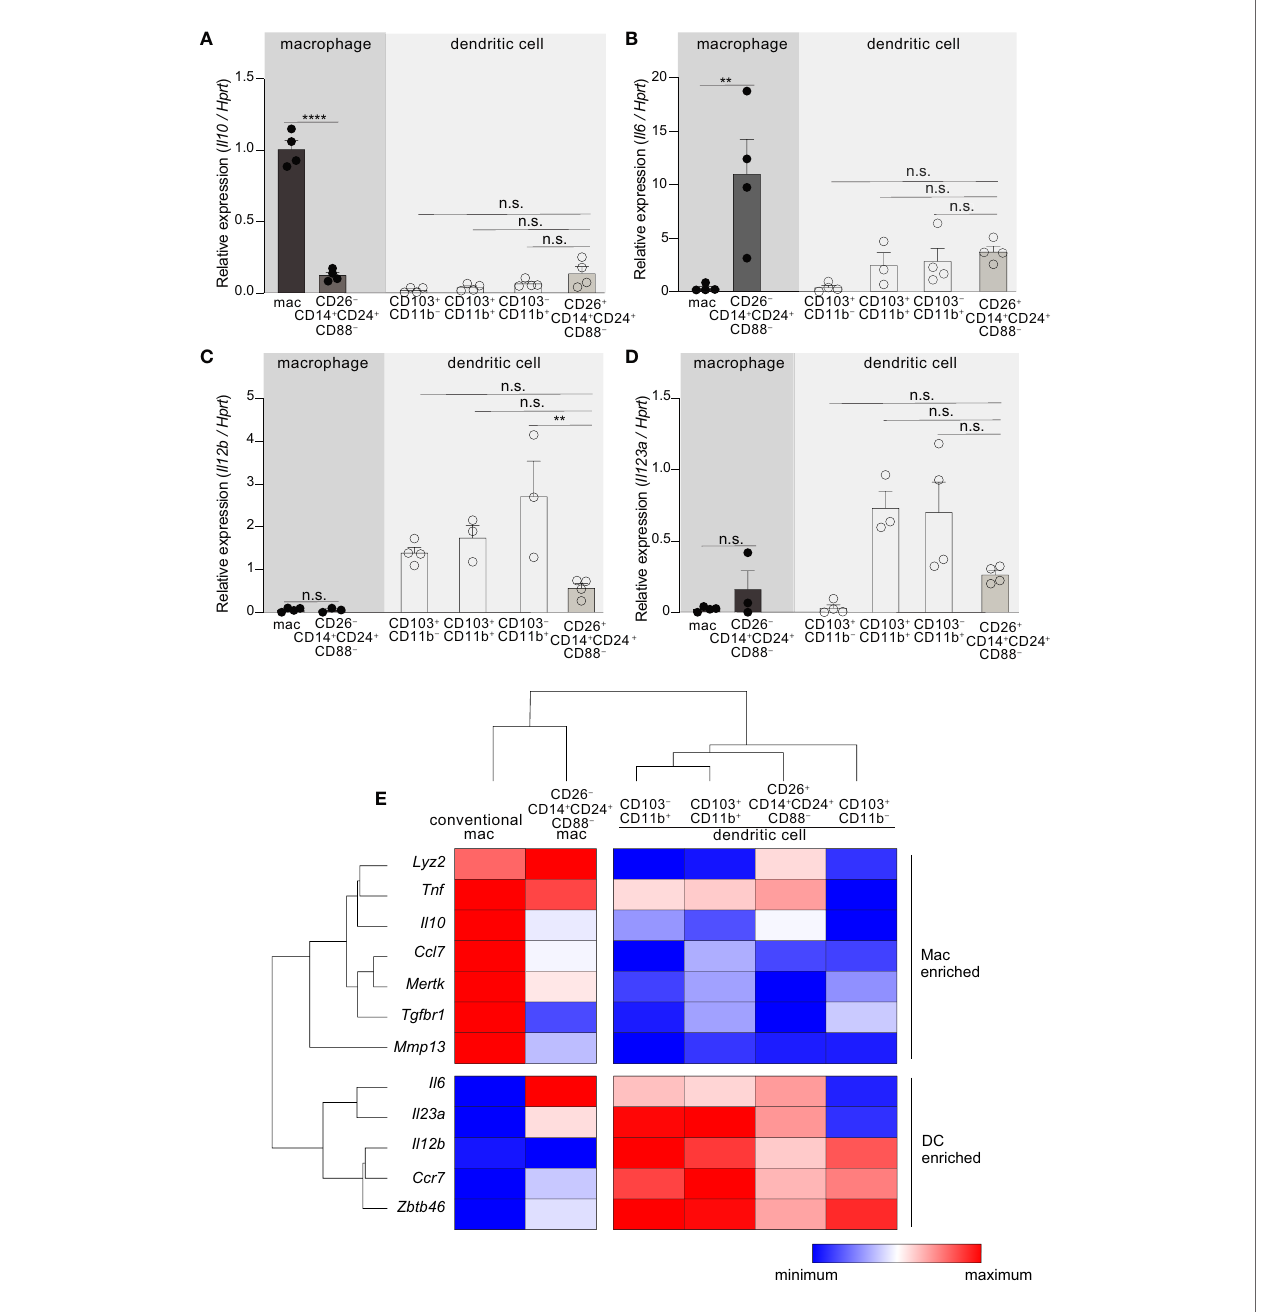
FIGURE 3 | CD26 – CD14 + CD24 + CD88 – macrophages are an atypical macrophage subset that expresses very little IL-10, and high levels of IL-6. Expression of Il10 (A) , Il6 (B) , Il12b (C) , and Il23a (D) in the indicated subset of C-LP mononuclear phagocyte. Each data point represents expression in sorted cells pooled from at least 5 mice. (E) Unsupervised, hierarchical cluster analysis of Euclidian distance between the indicated C-LP mononuclear phagocyte subset based on the relative expression of the indicated gene. Data within each gene set is relative to Hprt and normalized to the average expression among all cell types tested. Error bars represent mean ± SEM. ** p < 0.01, **** p < 0.0001, n.s., not signi fi cant (one-way ANOVA with Tukey ’ s post hoc